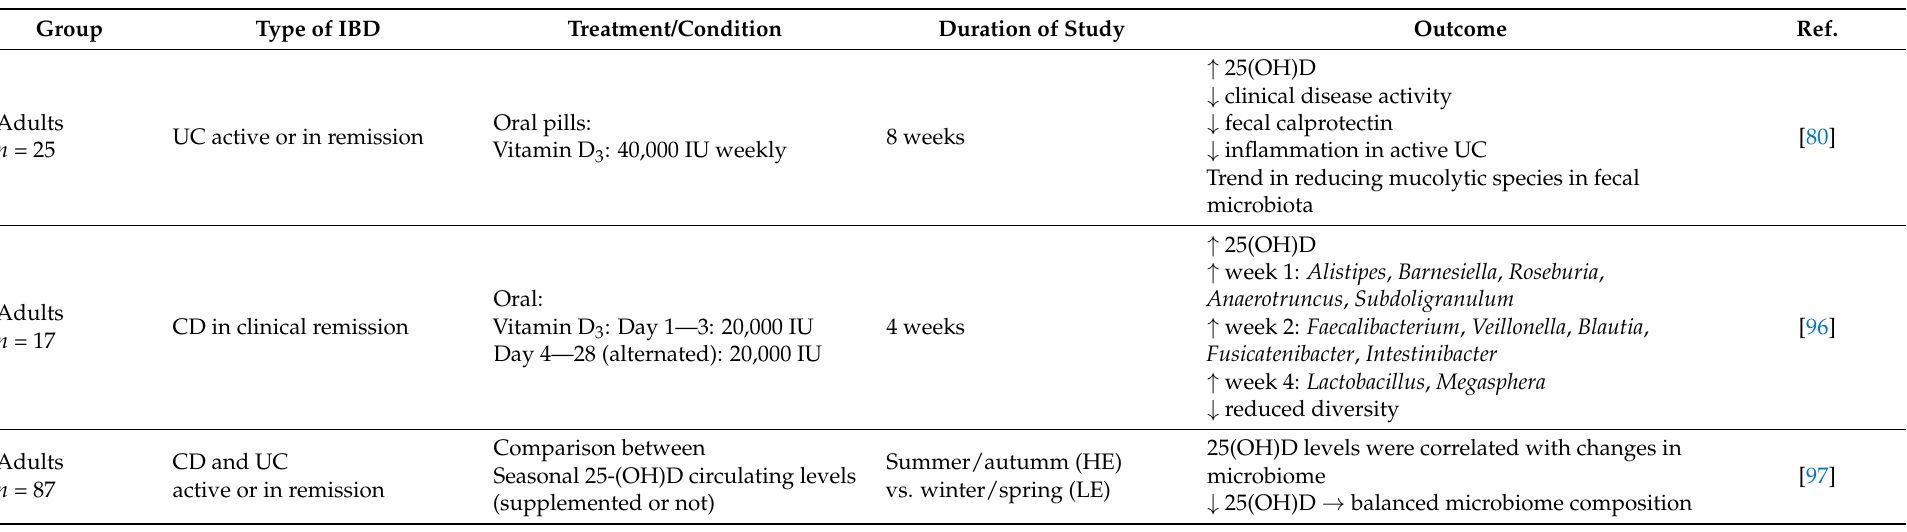
Table 1. Summary of published human studies outcomes evaluating vitamin D3 and its modulation of microbiota in inflammatory bowel disease.